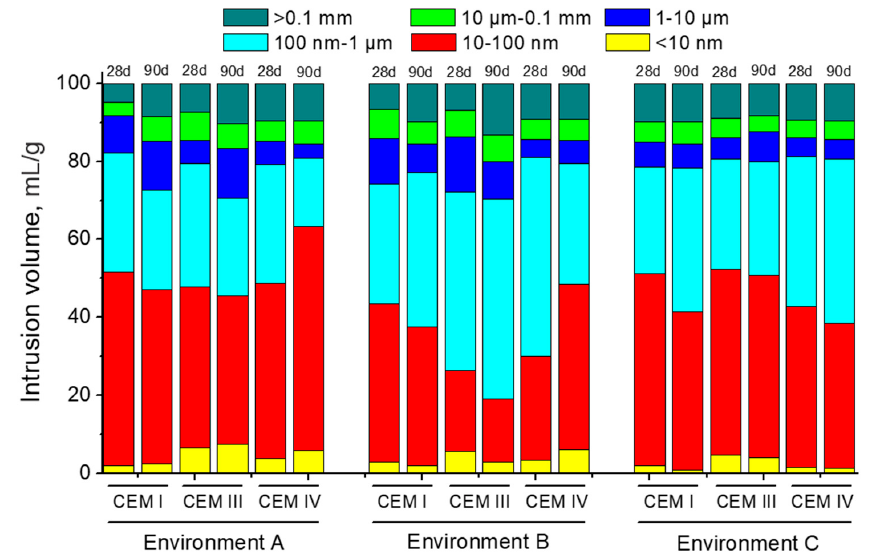
Figure 8. Pore size distributions for CEM I, III and IV mortars obtained for each environment.